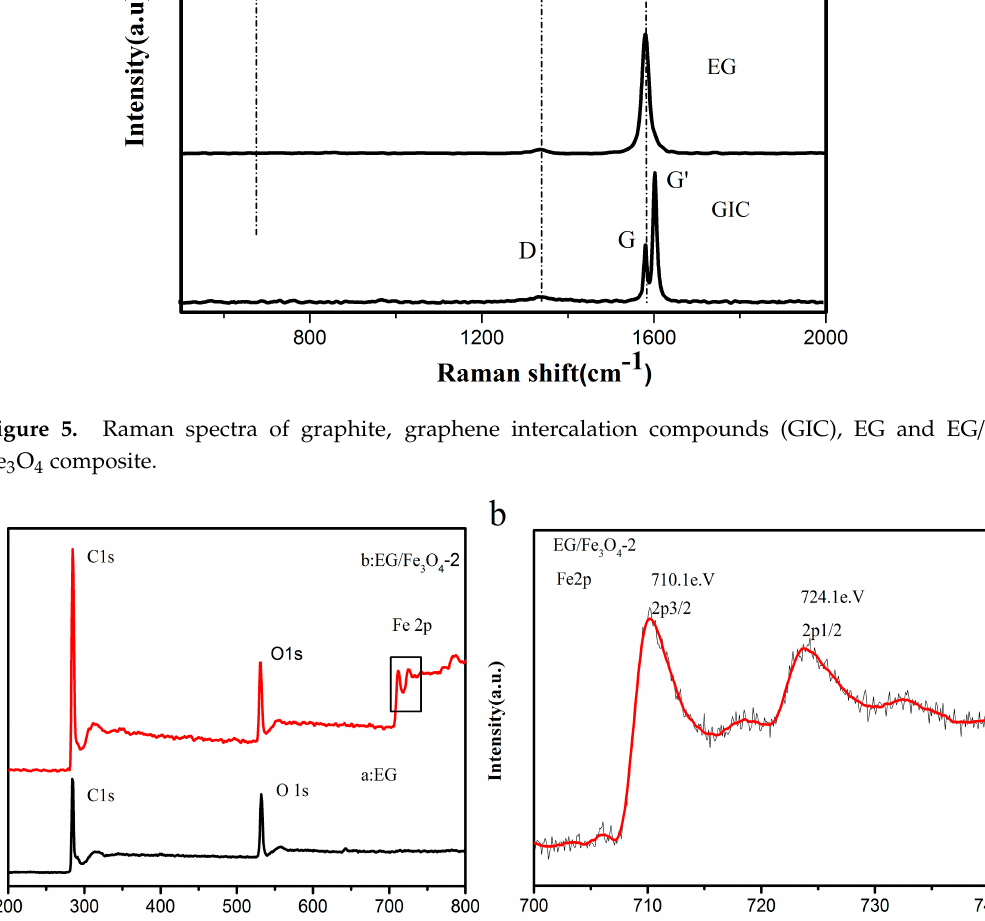
Figure 5. Raman spectra of graphite, graphene intercalation compounds (GIC), EG and EG/ Fe 3 O 4 composite.